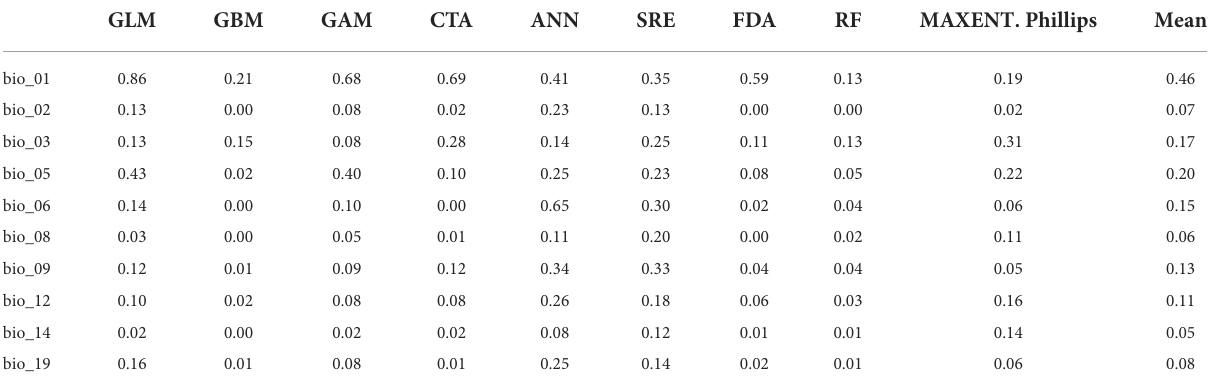
TABLE 2 The relevance scores of the selected bioclimatic variables, both overall and by the algorithm. GLM GBM GAM CTA ANN SRE FDA RF MAXENT.